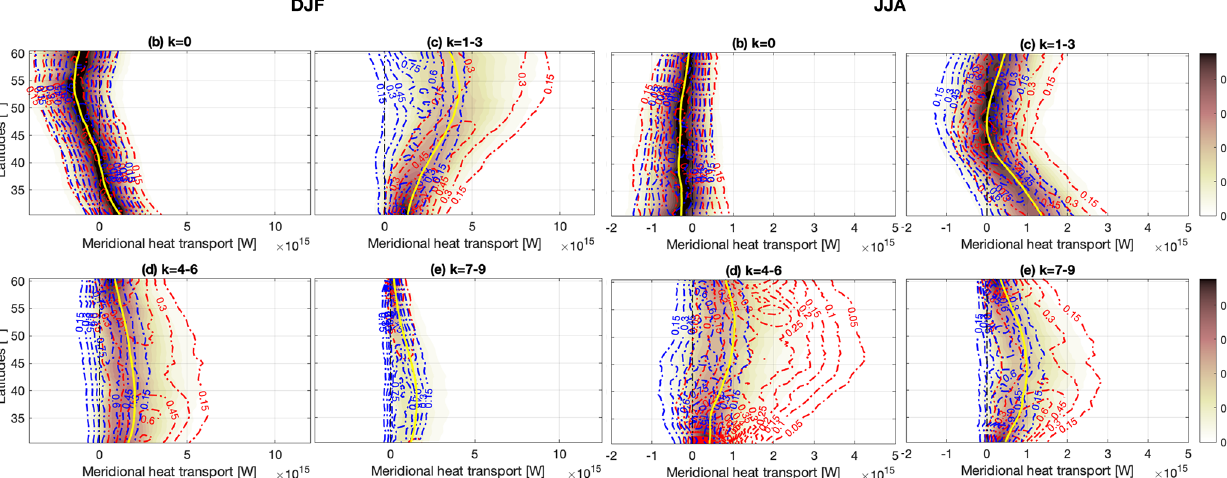
Weather Clim. Dynam., 3, 1037–1062,